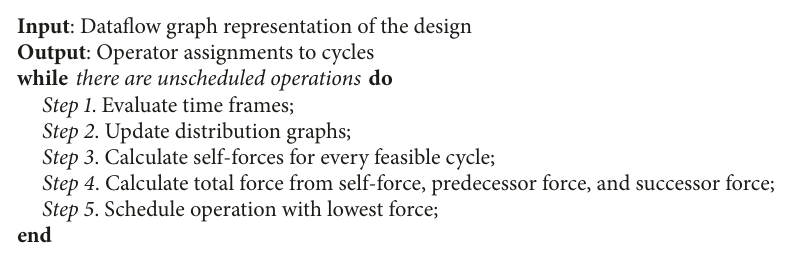
Algorithm 2: Force-Directed